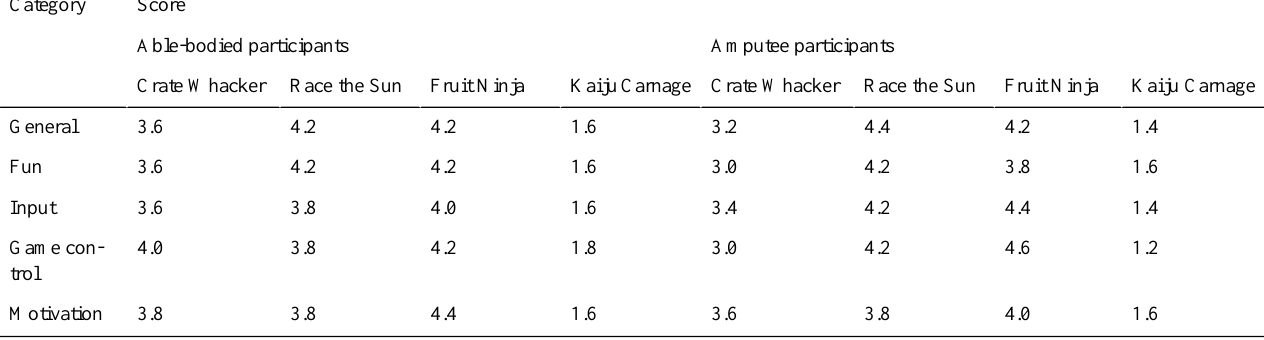
Table 3. Results of the user evaluation